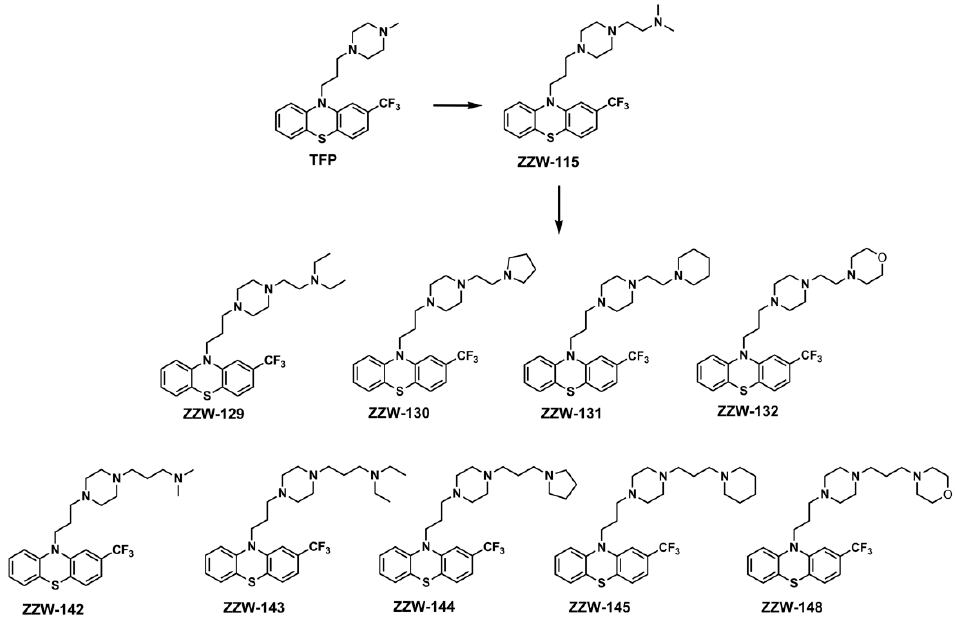
Figure 1. Structures of the ZZW-115-derived compounds used in this work. The structures of TFP and ZZW-115 are also shown for comparison.